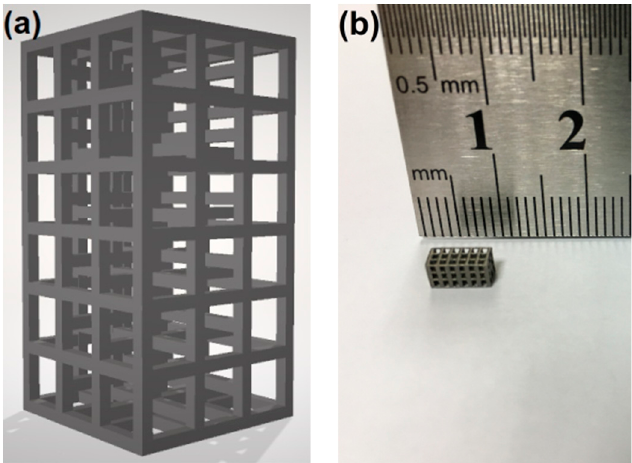
Figure 1. ( a ) Computer design model of rectangular a SLM-Ti scaffold and ( b ) a manufactured SLM-Ti scaffold.